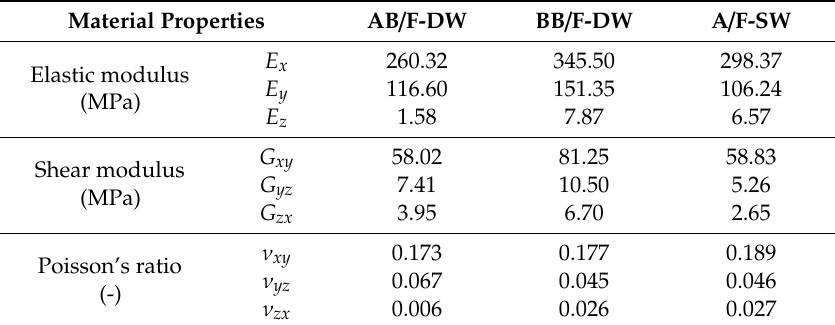
Table 9. Equivalent material properties for the corrugated paperboard samples.